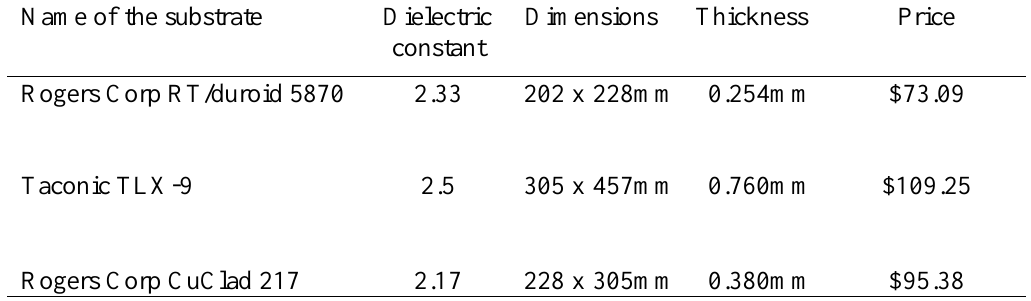
Table 1. Price comparison of high-quality